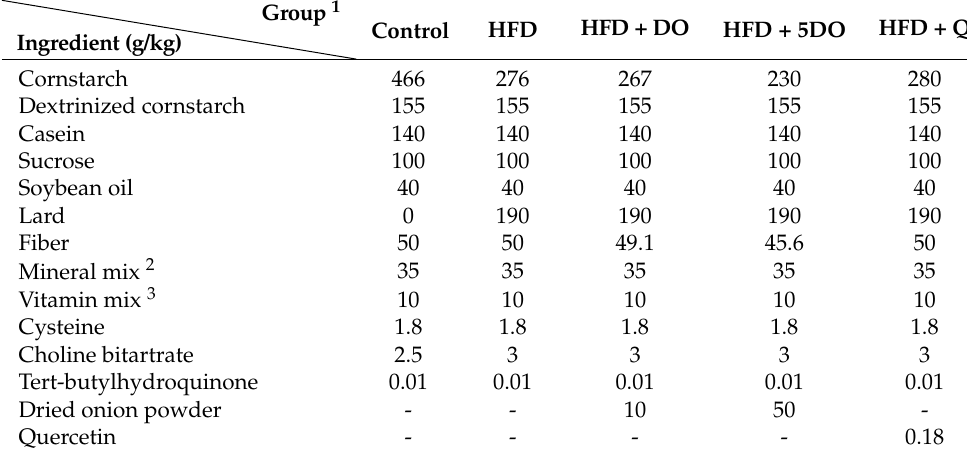
Table 7. Composition of experimental